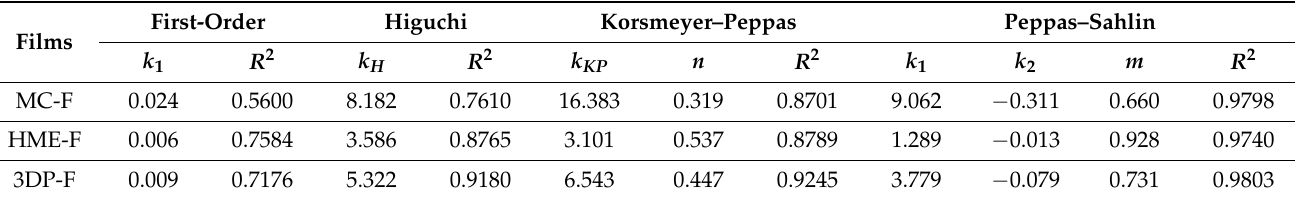
Table 3. The model fitting parameters of the dissolution study in